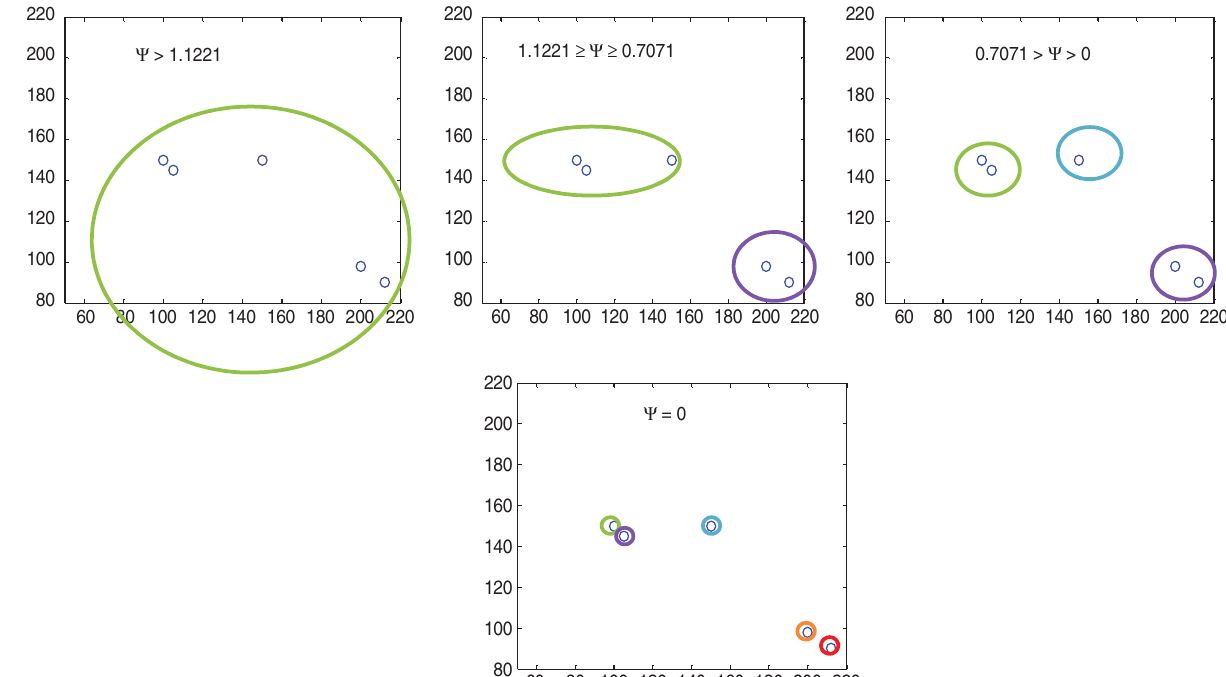
Figure 22: Hierarchical clustering progression on reducing the inconsistency coefficient ( Ψ